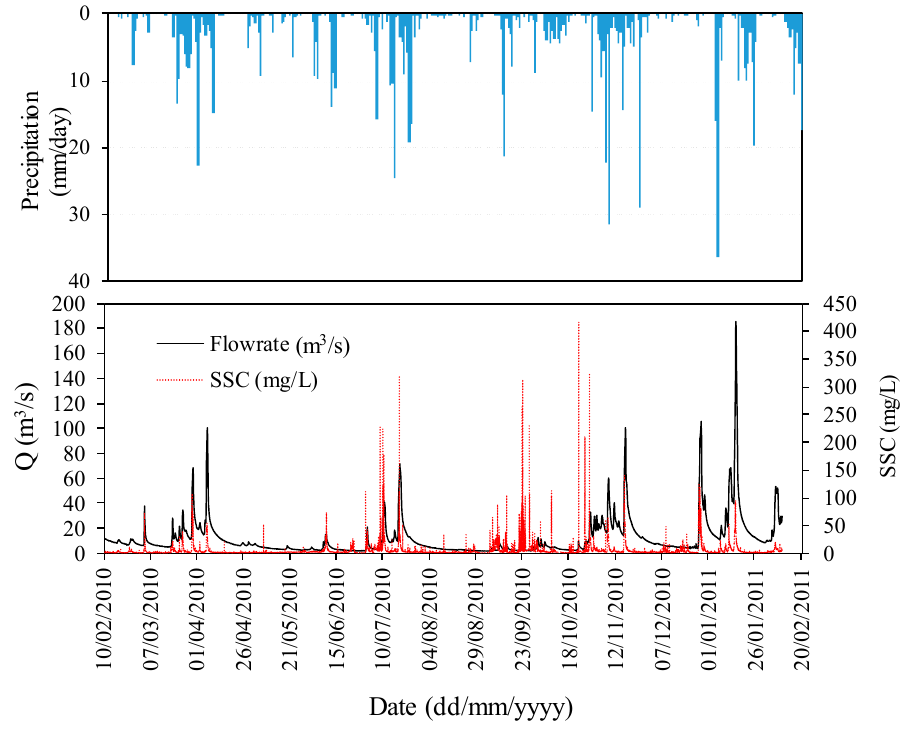
Figure 2. Flowrate and suspended sediment concentration values over the study period on the River Bandon (10 February 2010 to 09 February 2011).